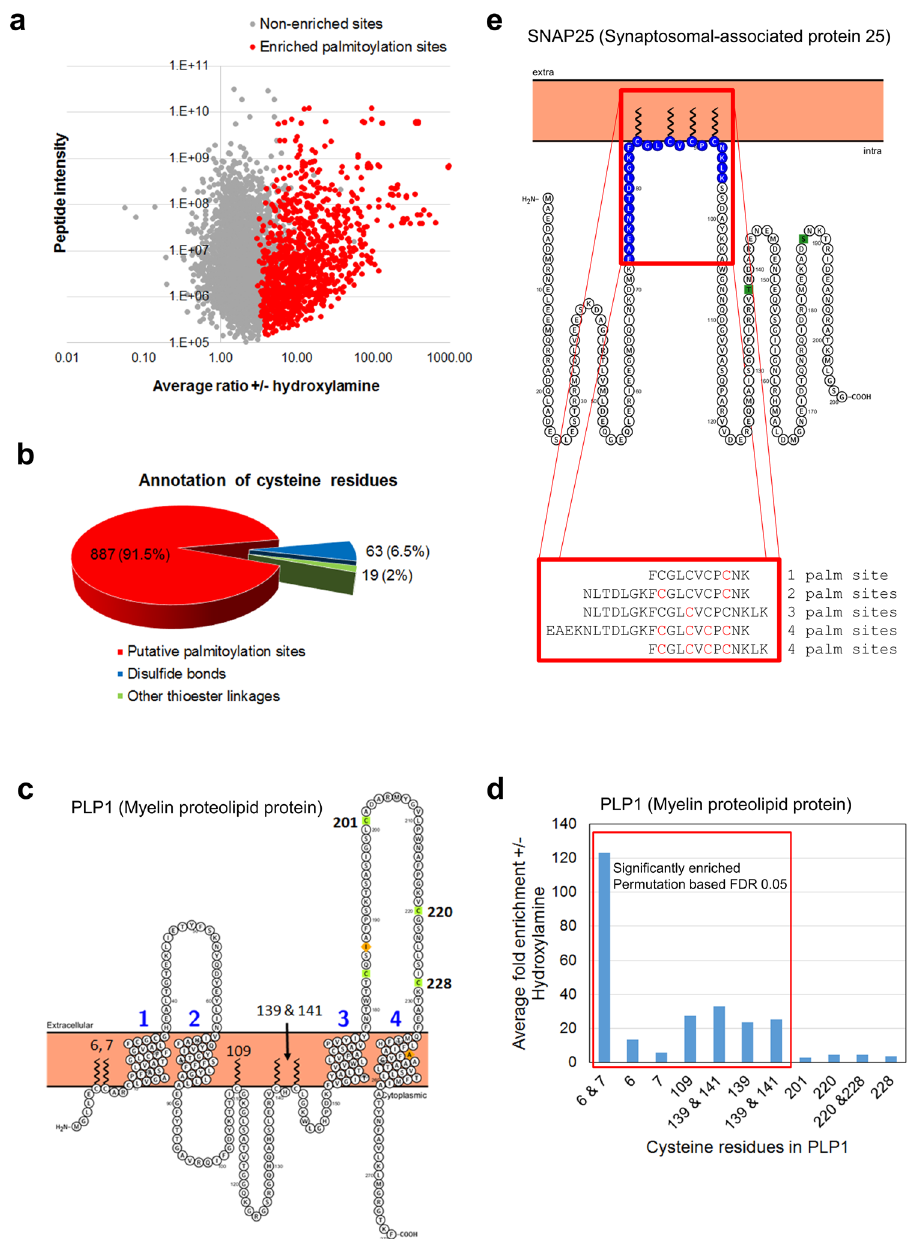
Figure 2. Identification of palmitoylation sites by analysis of peptide enrichment in + / − hydroxylamine treated samples. ( a ) Six biological replicates (2 technical replicates for each) each for + / − hydroxylamine treatments were used for label free quantification. Data points in red are significantly enriched (0.05 permutation- based FDR) in the hydroxylamine treated compared to the control set. ( b ) Putative palmitoylation sites were annotated with data from UniProt to find potential false positives. 2% of sites are annotated as being involved in other types of thioester linkages and 6.5% are potentially involved in predicted disulfide bonds but sites for disulfide bonds and palmitoylation are not mutually exclusive. ( c ) PLP1 contains multiple sites of palmitoylation and disulfide bonds. 5 palmitoylation sites were significantly enriched by ssABE whilst peptides bearing cysteine resides involved in the formation of disulfide bonds were not enriched upon treatment with hydroxylamine ( d ). ( e ) High coverage of multi-palmitoylated proteins such as the t-snare SNAP25 is obtained using ssABE. All 4 known palmitoylation sites on SNAP25 were identified and multiple palmitoylation states were independently observed (on Cys 85, 88, 90 & 92) on a number of different